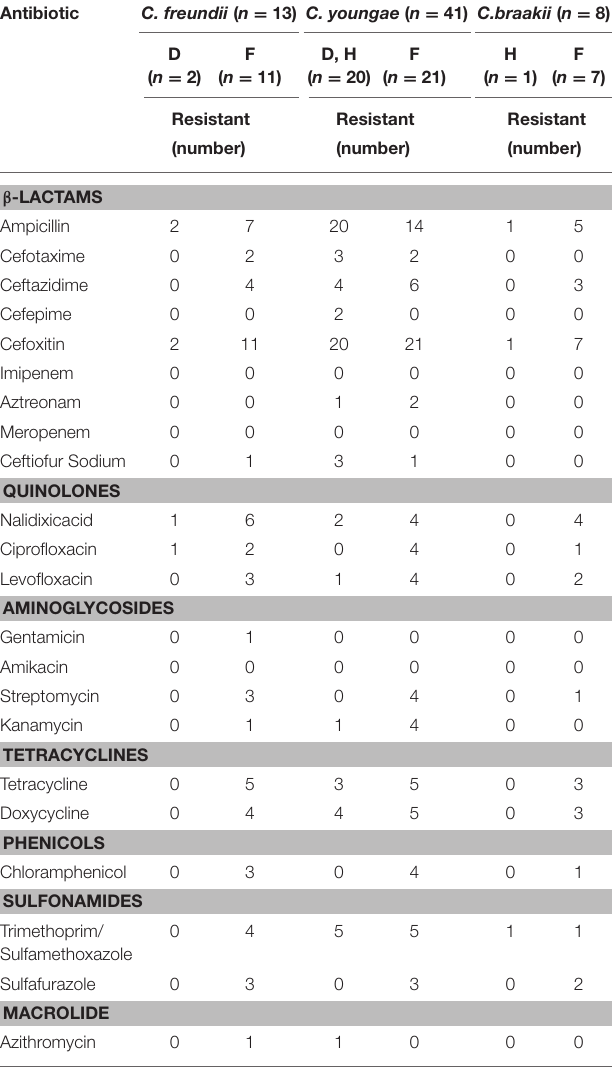
TABLE 2 | Number of isolates non-susceptible to antibiotics by species and source. Antibiotic